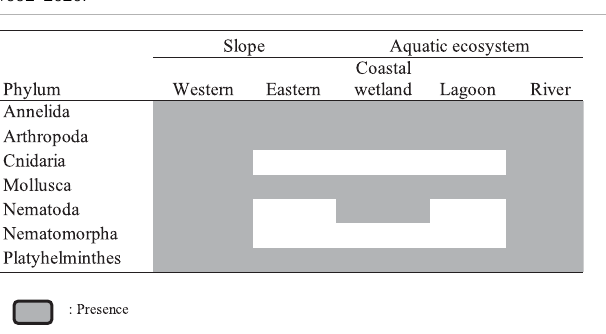
TABLE 2 | Classes of macroinvertebrates by hydrographic slope and aquatic ecosystem, according to research studies carried out between years 1992 – 2020.